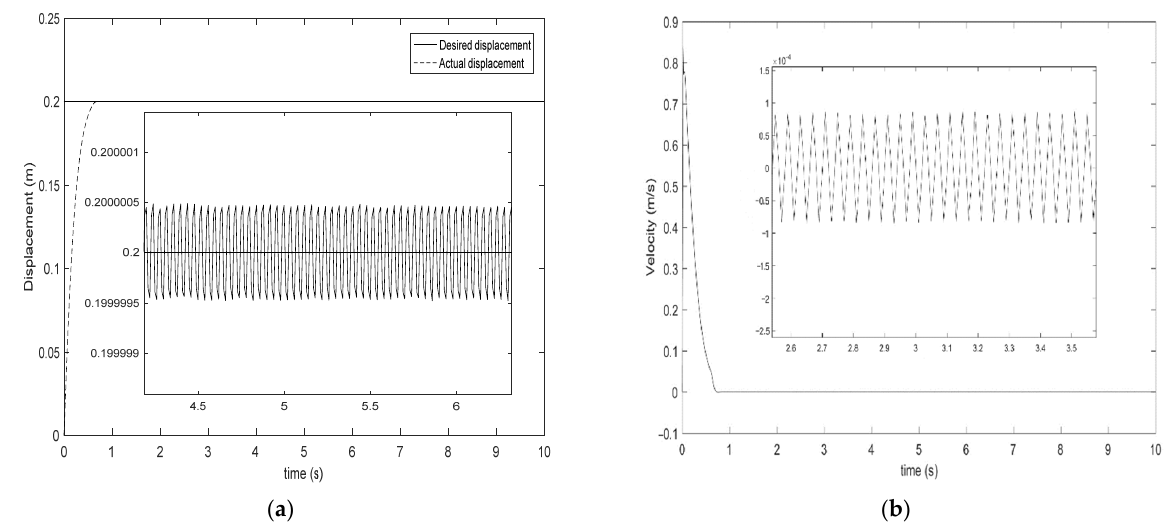
Figure 9 . Tracking trajectory of SMC algorithm using exponential reaching law. ( a ) Displacement buffeting curve and ( b ) velocity buffeting curve.